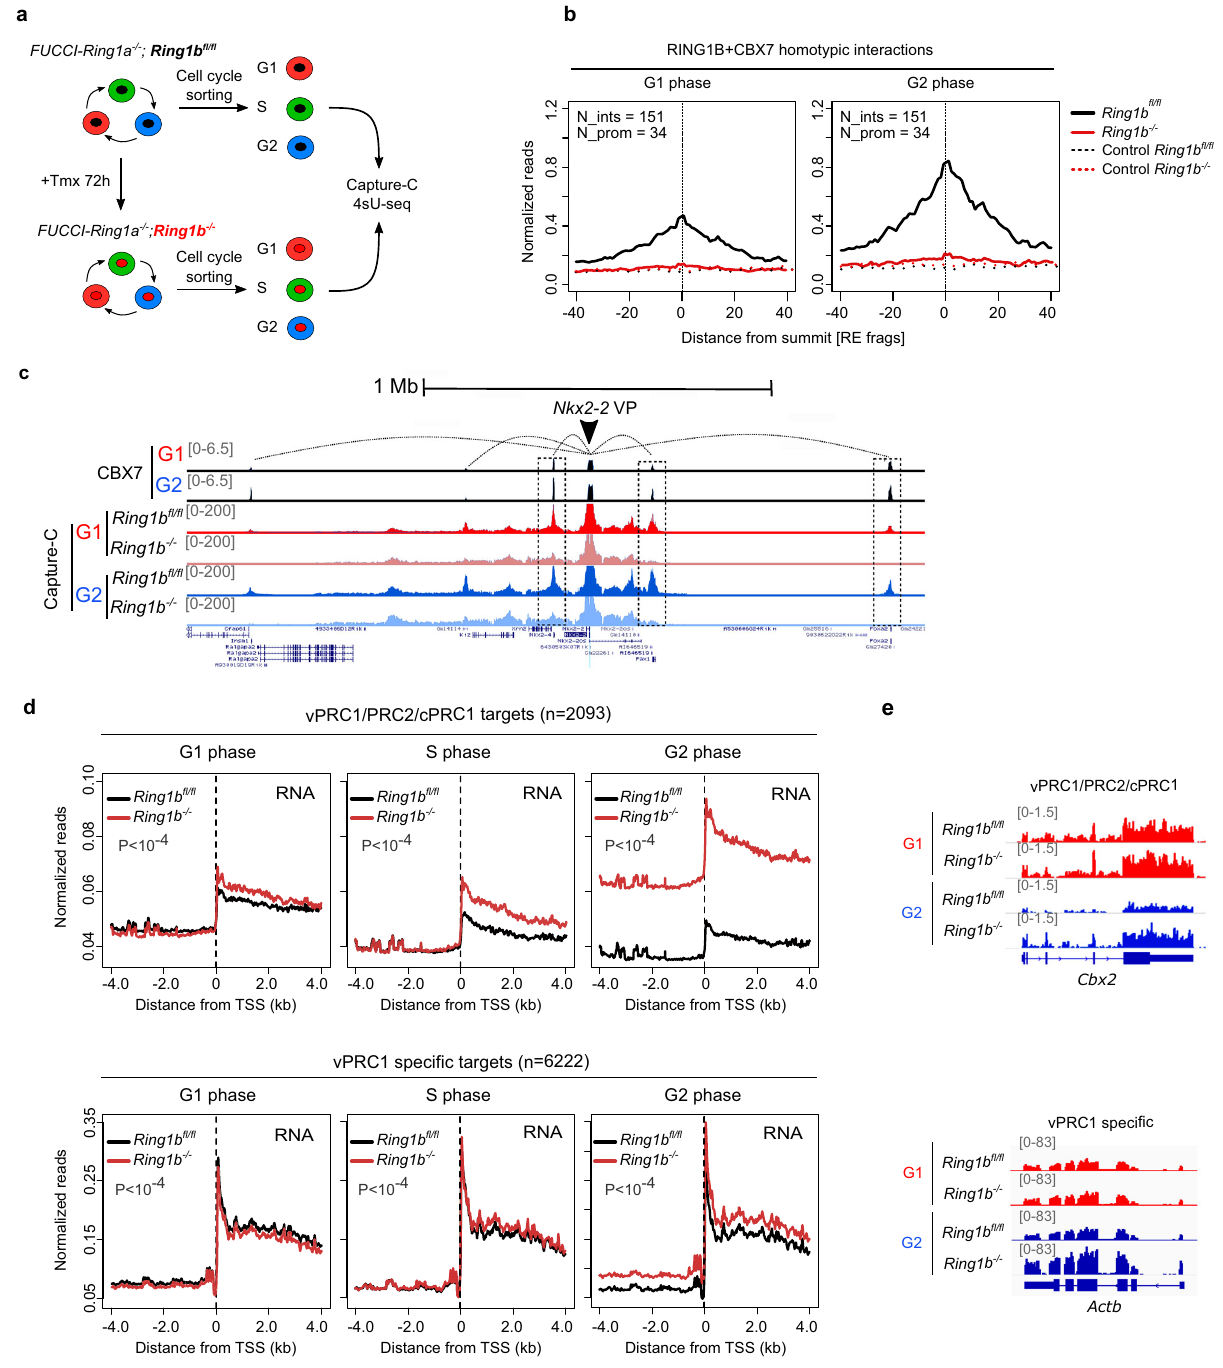
Fig. 5 | Depletion of RING1B perturbs 3D chromatin interactions and tran- scriptional repression in G2 phase. a Scheme representing the experimental setup to study 3D chromatin interactions and nascent RNA in PRC1 null cells. Ring1a – / – ; Ring1b fl / fl ; Rosa26 :: CreERT2 ;FUCCI (FUCCI- Ring1a – / – ;Ring1b fl / fl ) mESCs were treated with Tmx for 72h, cell cycle sorted and subjected to Capture-C and 4sU-seq analyses. b Average normalized reads of 3D chromatin interactions (number of interactions = 151) measured by Capture-C of RING1B+CBX7-bound regions involving at least one promoter (number of promoters=34) in Ring1b fl / fl (blackline)and Ring1b – / – (red line)cellsduringG1(left)andG2(right)phases.The X -axis represents the distance from the summit of the interaction peak measured as a function of DpnII restriction fragments. Dashed lines show enrichment at